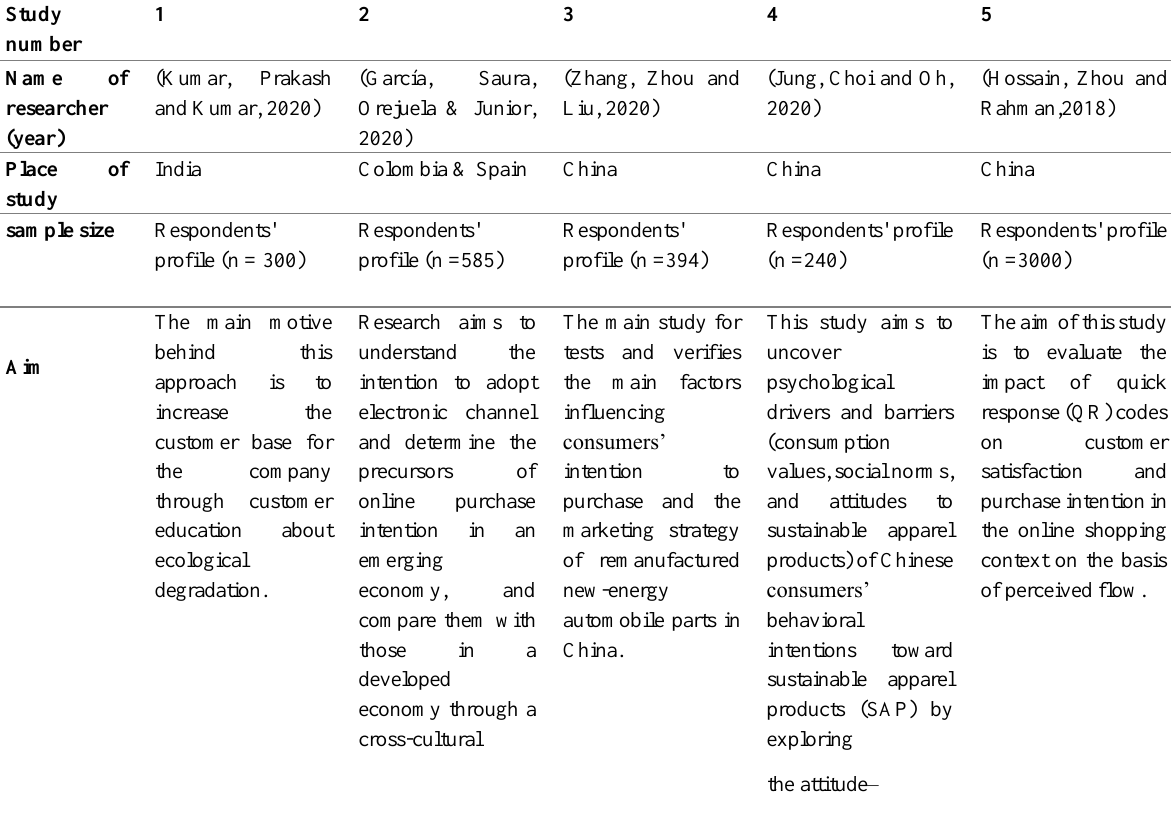
Table 2: Empirical studies for Purchase